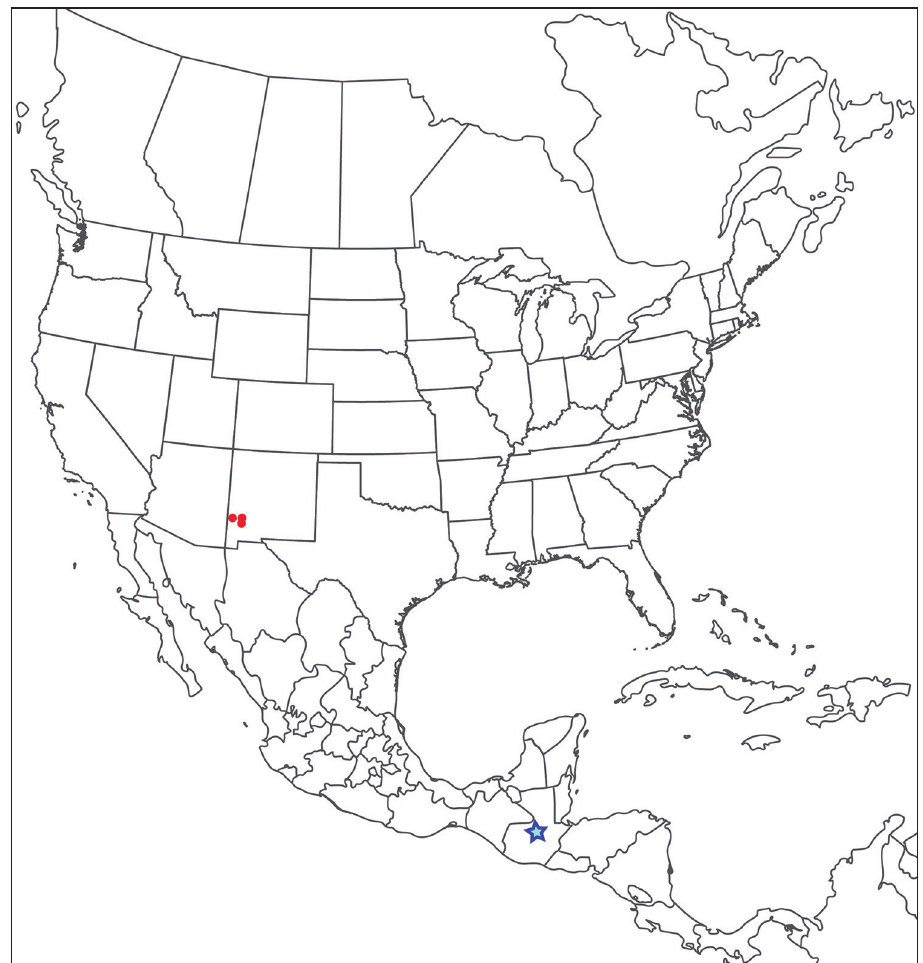
Figure 123. Torrenticola lamellipalpis distribution. Blue star represents type locality (K.O. Viets 1977b); and red circles represent new records and material